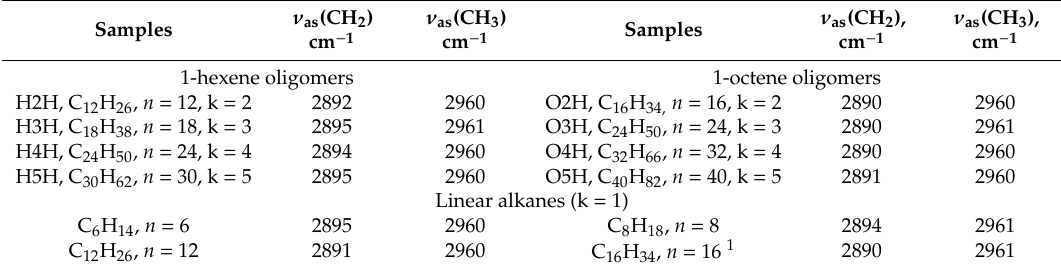
Table 4. Peak positions of ν as (CH 2 ) and ν as (CH 3 ) bands for the hydrogenated 1-hexene and 1-octene oligomers as well as for linear alkanes.